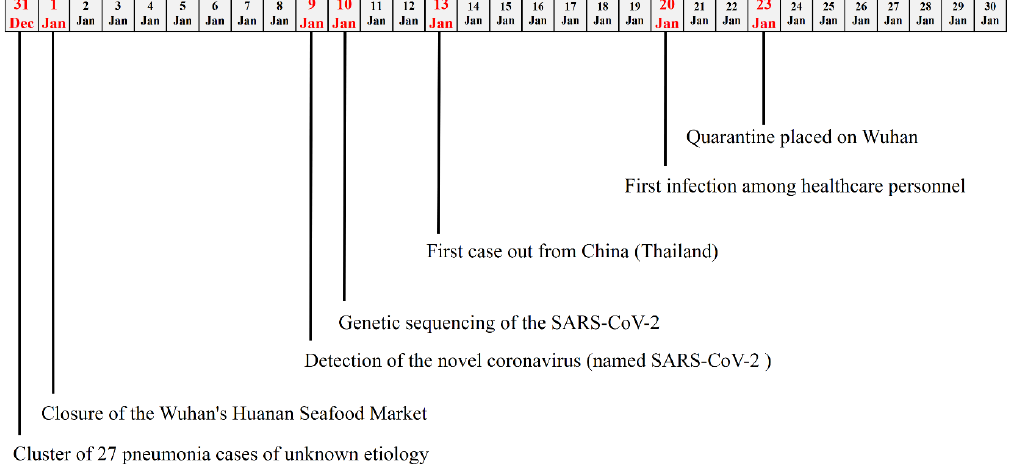
Figure 1. Timeline of the key events observed in the first month of the 2019 severe acute respiratory syndrome coronavirus 2 (SARS-CoV-2) outbreak.